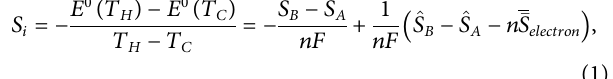
Frontiers in Energy Research |